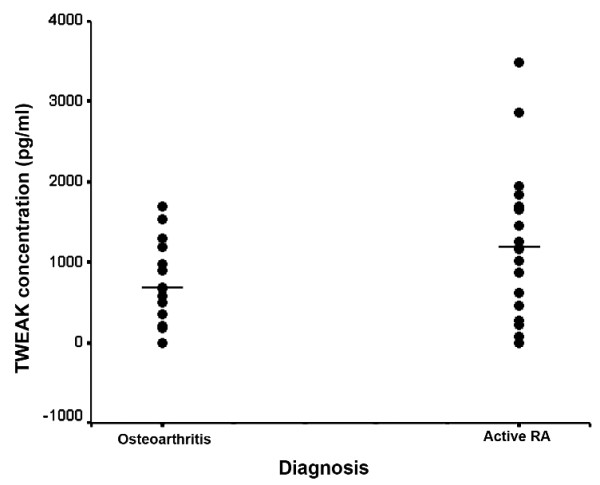
Levels of soluble TWEAK in synovial fluids from patients with RA and OA. Scatter plot of sTWEAK levels in the synovial fluids obtained from active RA (n = 17) and OA (n = 16). Horizontal lines reflect mean values of sTWEAK level in each group.